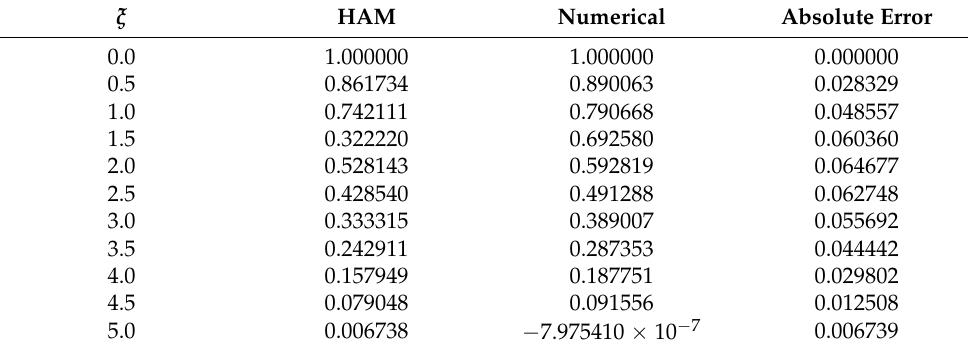
Table 6. Comparison of HAM and numerical methods for temperature function when β = 0.1,